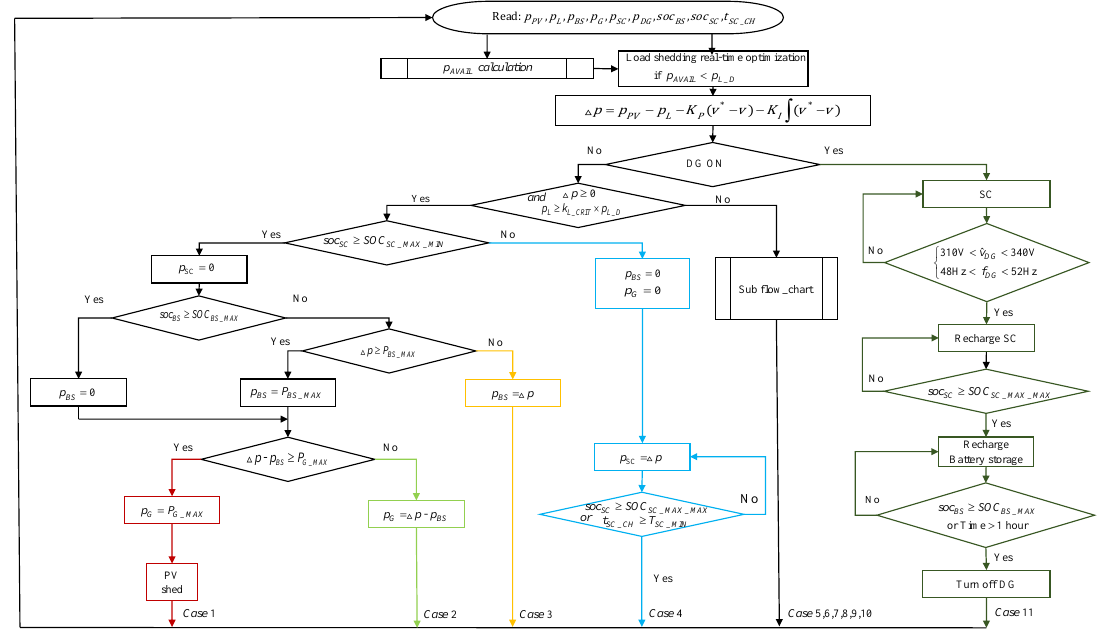
Figure 2. Flowchart of operational power control and management algorithm.